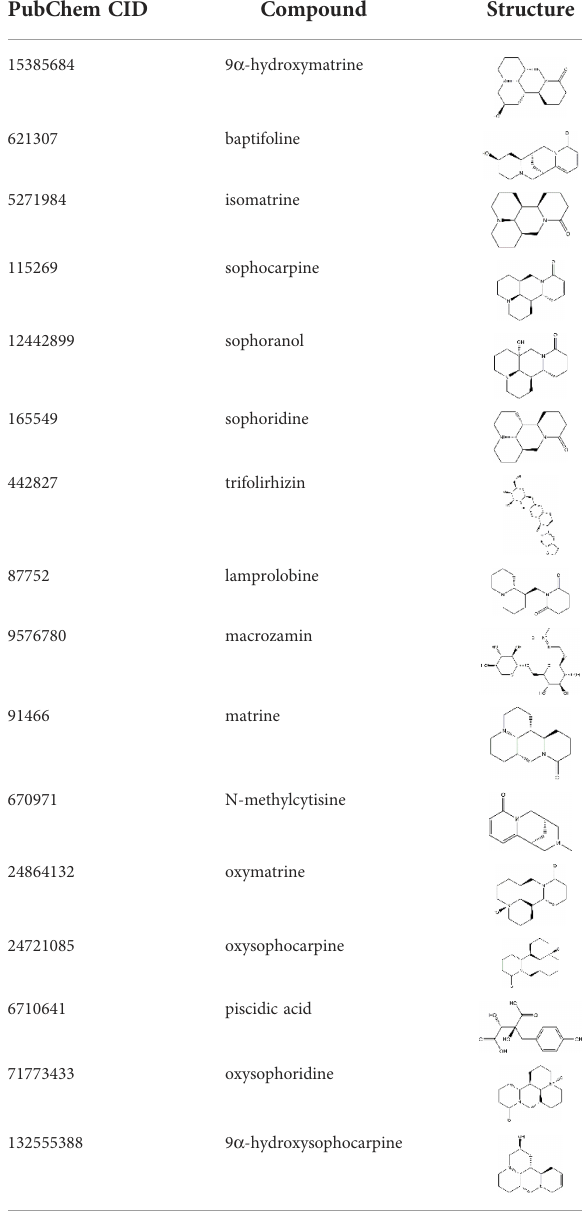
TABLE 1 Information on the active ingredients of